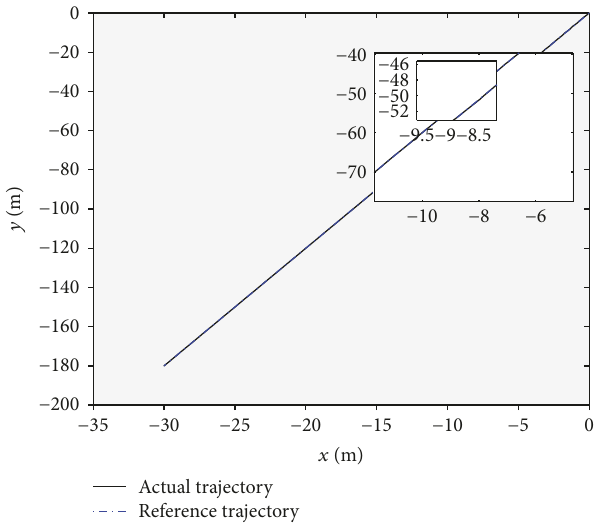
Figure 3: Position tracking (line-path tracking).